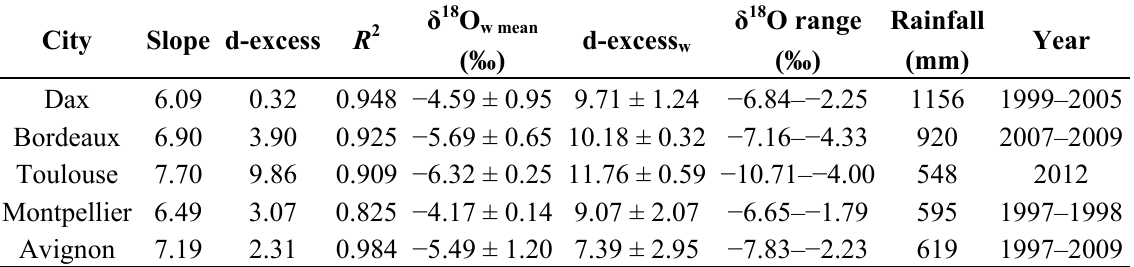
Table 2. Comparison of the isotopic features of the GNIP stations and our Toulouse